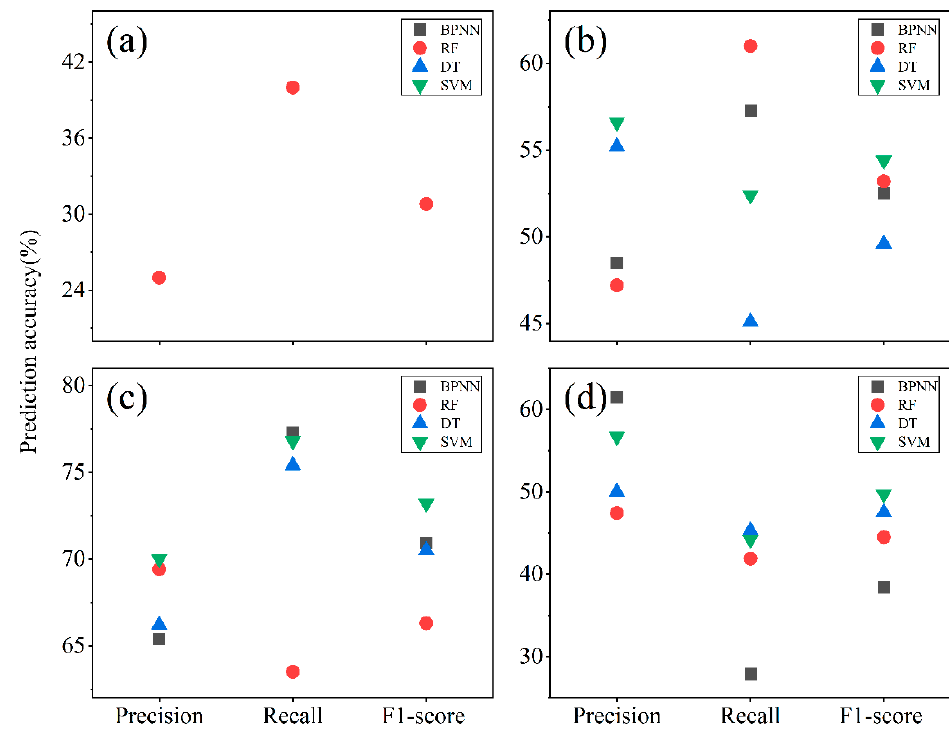
Figure 6. Plot showing comparisons of the prediction accuracy values for four machine learning models associated with different levels of cultivated land including ( a ) Level 1 (the BPNN, DT, and SVM models involves loss of some data, and the missing precision, recall, and F1-score are assigned values of 0), ( b ) Level 2, ( c ) Level 3, and ( d ) Level 4.